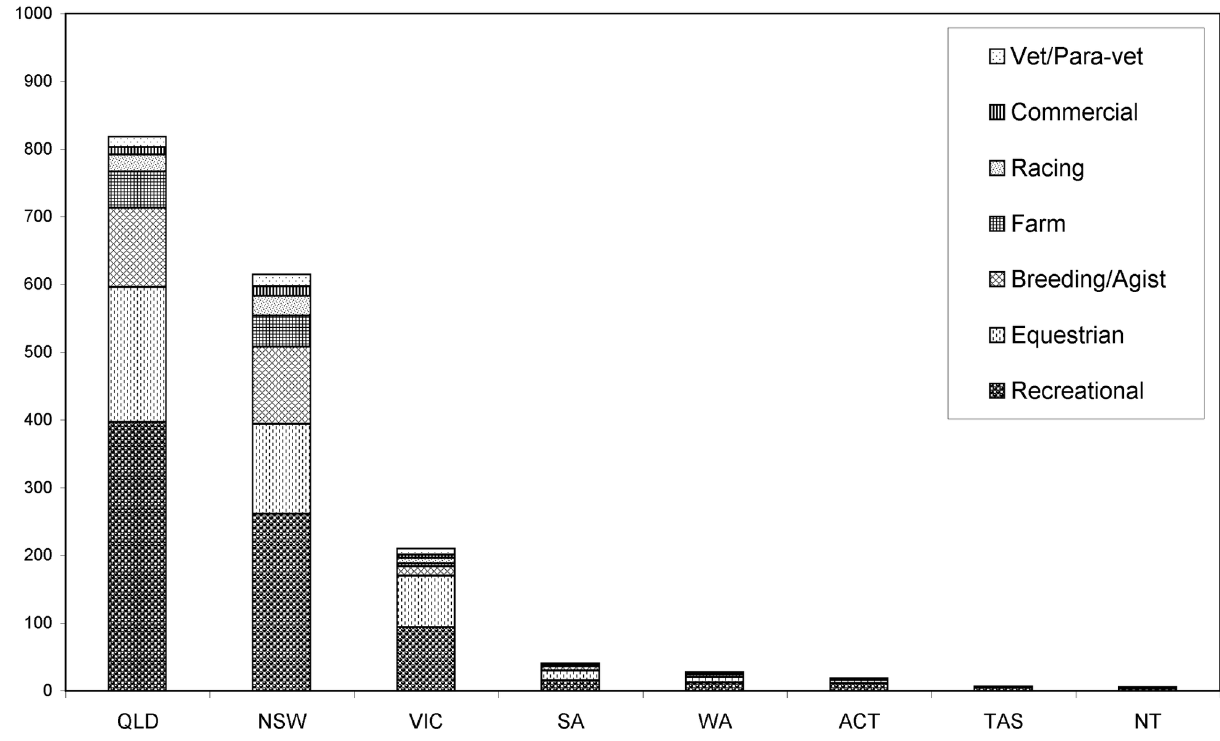
Figure 1. The number of respondents completing the questionnaire from each Australian state or territory with industry sector composition. (QLD = Queensland, NSW = New South Wales, VIC = Victoria, SA = South Australia, WA = Western Australia, ACT = Australian Capital Territory, TAS = Tasmania, and NT = Northern Territory.)